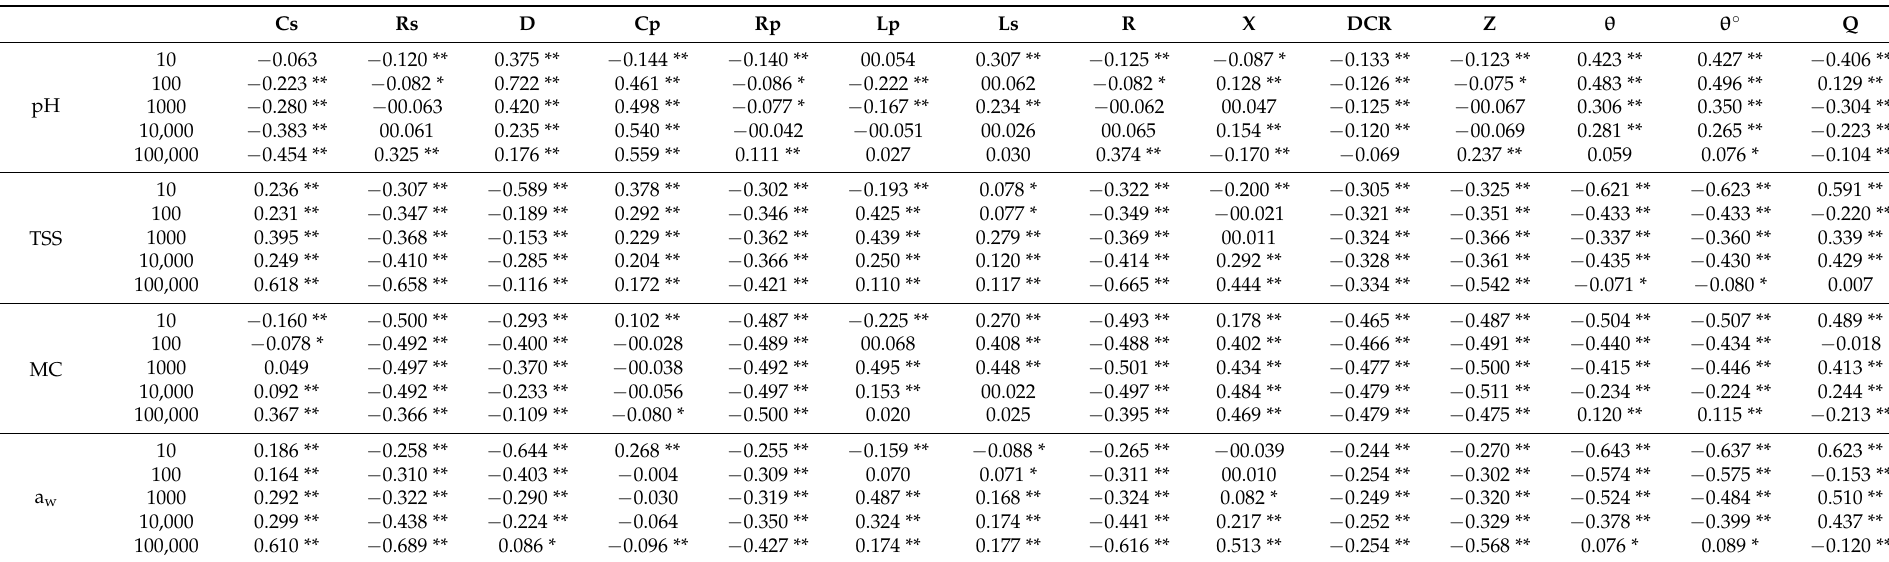
Table 5. The correlation between the pH, total soluble solids (TSS), water activity (a w ), and moisture content (MC) of the stored date fruits and the electrical parameters at various